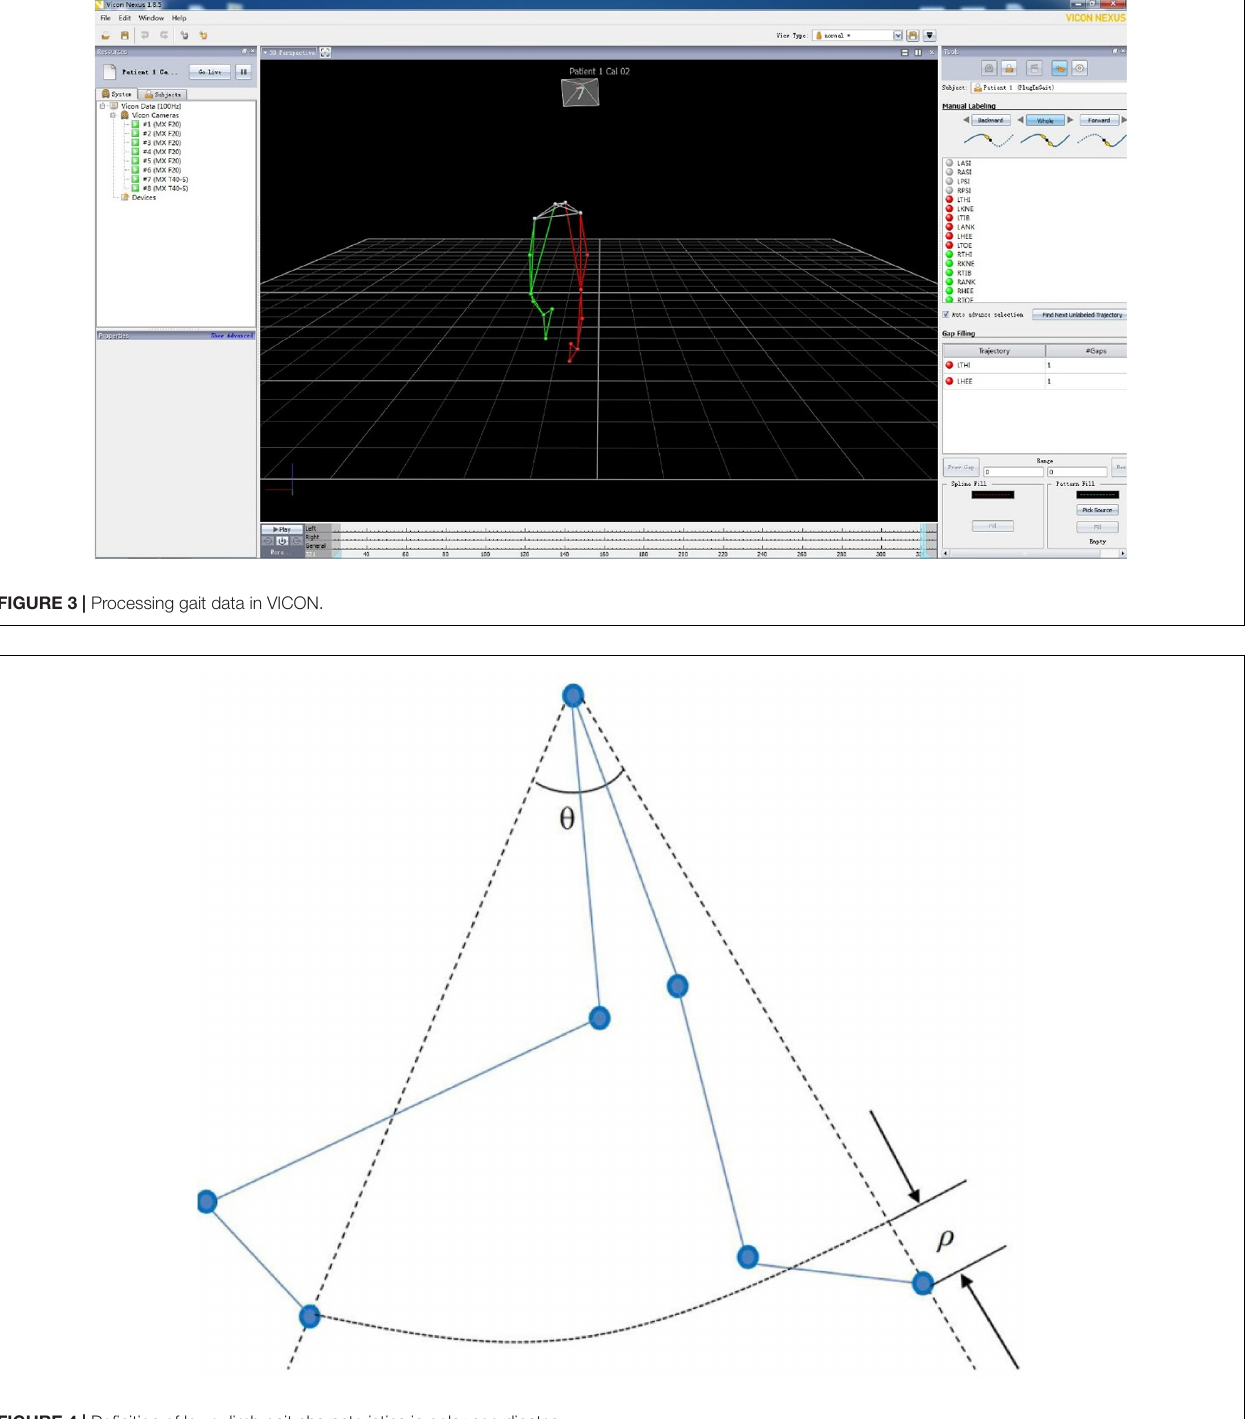
FIGURE 4 | Definition of lower limb gait characteristics in polar